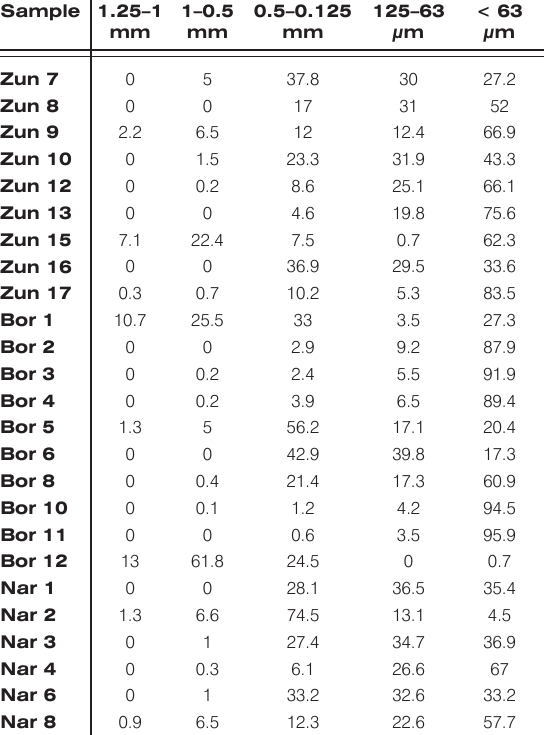
Table 2. Distribution of particles in